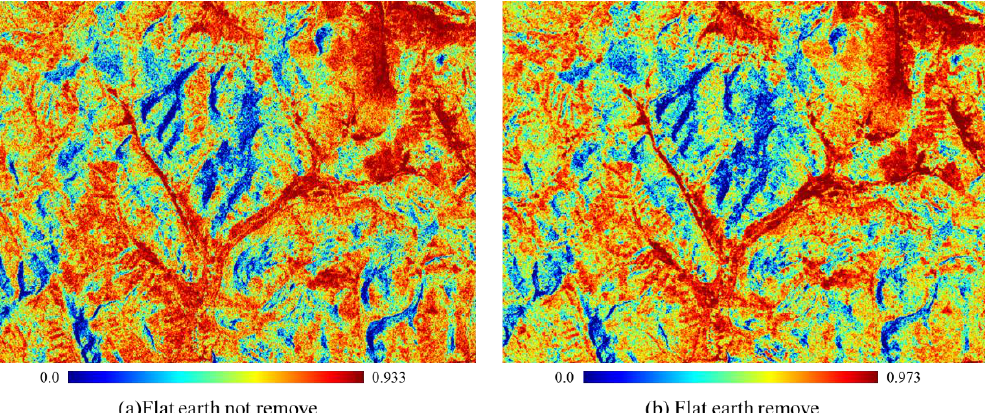
Figure 10. The effect of flat earth on coherence